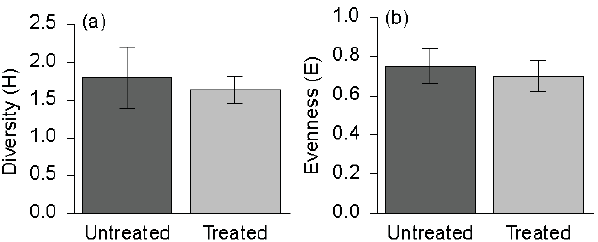
Figure 3. Understory plant diversity indices at the study level between untreated and treated areas: